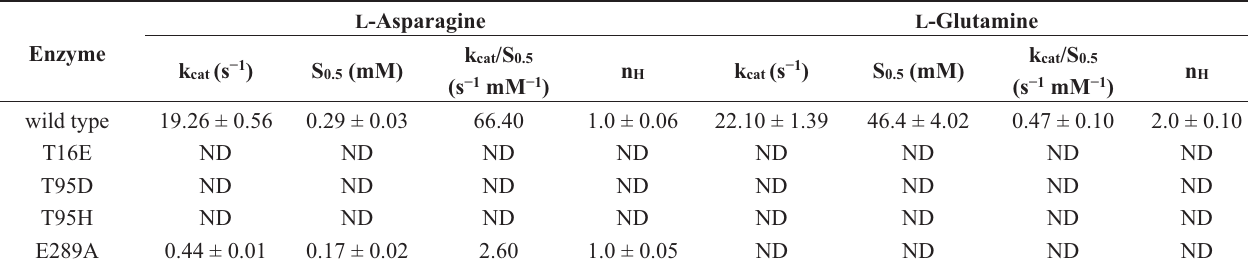
Table 1. Apparent kinetic constants of Helicobacter pylori CCUG 17874 type II enzyme (HpASNase) wild type and mutant